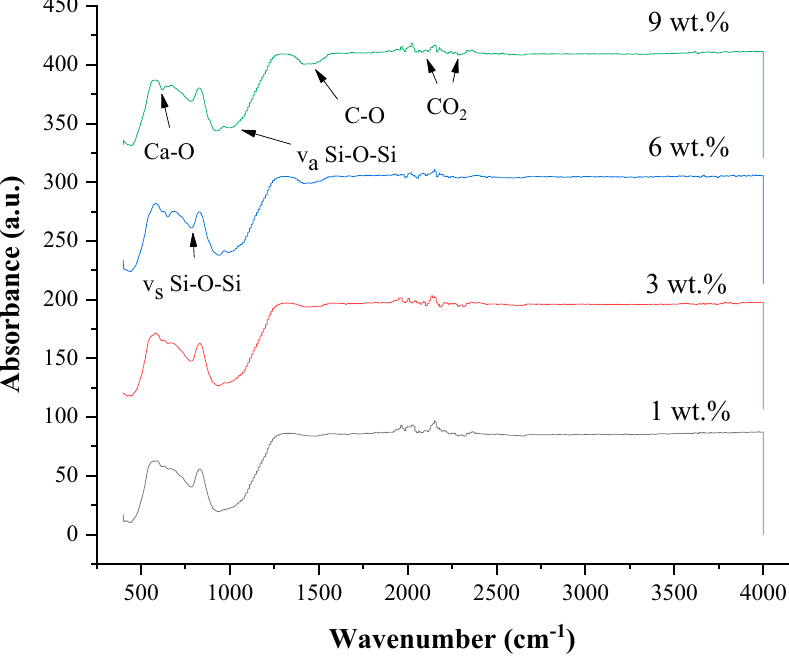
Figure 9. FTIR band at different content ES.